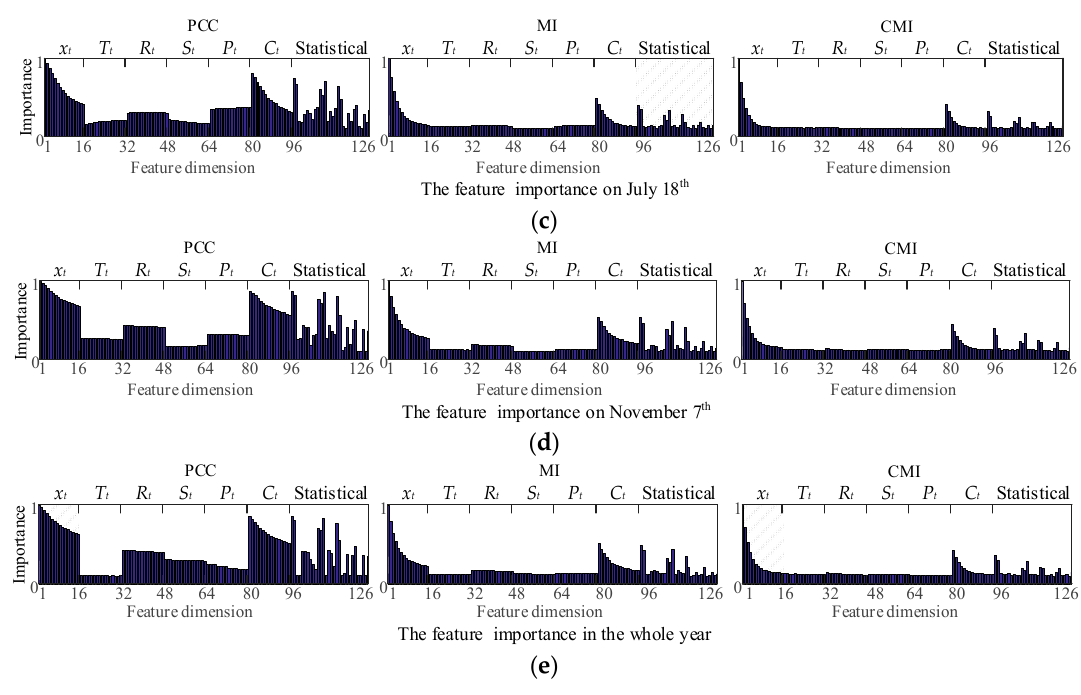
Figure 5. Results of the features’ correlation analysis. ( a ) The correlation analysis results on 21 January; ( b ) The correlation analysis results on 17 April; ( c ) The correlation analysis results on 18 July; ( d ) The correlation analysis results on 7 November; ( e ) The correlation analysis results of the whole year. Table 4. Feature numbers of the most important 30 dimensions.